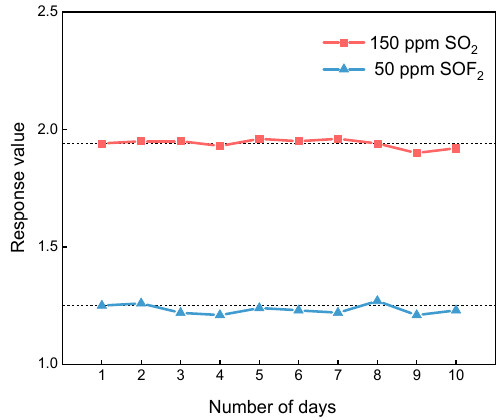
Figure 9. Long-term stability of SnS 2 gas sensor.